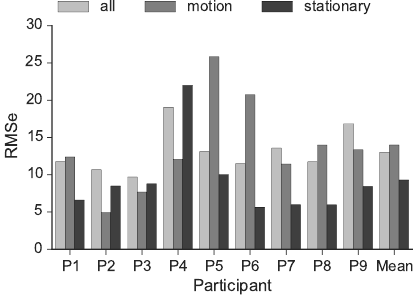
Figure 7: Heart rate estimation: RMSe analysis per participant, where the reference heart rate was be- tween 40 and 150 bpm. RMSe was analysed for three activity clusters: all, motion (“stairs”, “walk”, and “jog”), and stationary (“eat”, “read”, and “screen”). formance for activity recognition, screen-use detection, and heart rate estimation in this work show that the